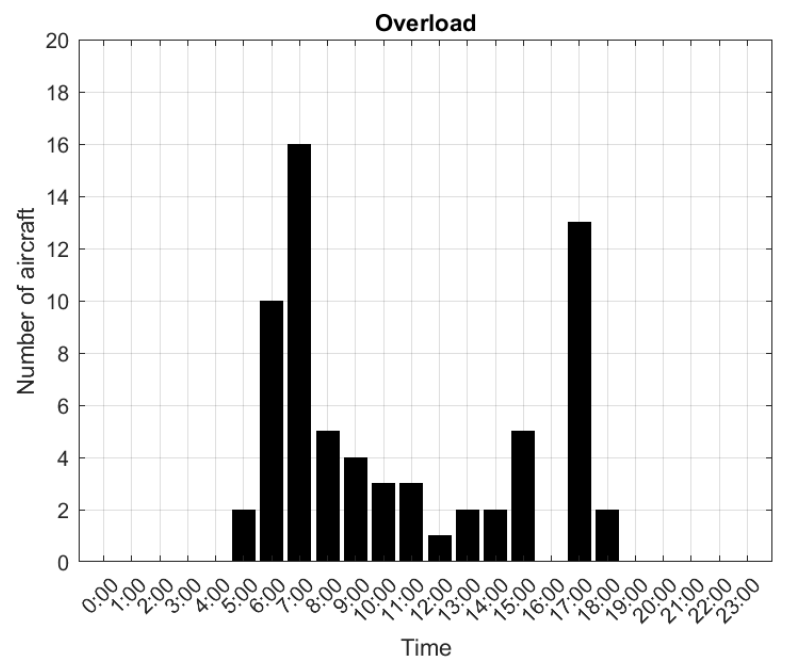
Figure 3. Analysis of the sector overload from NEST. Incident A (07:43 UTC).